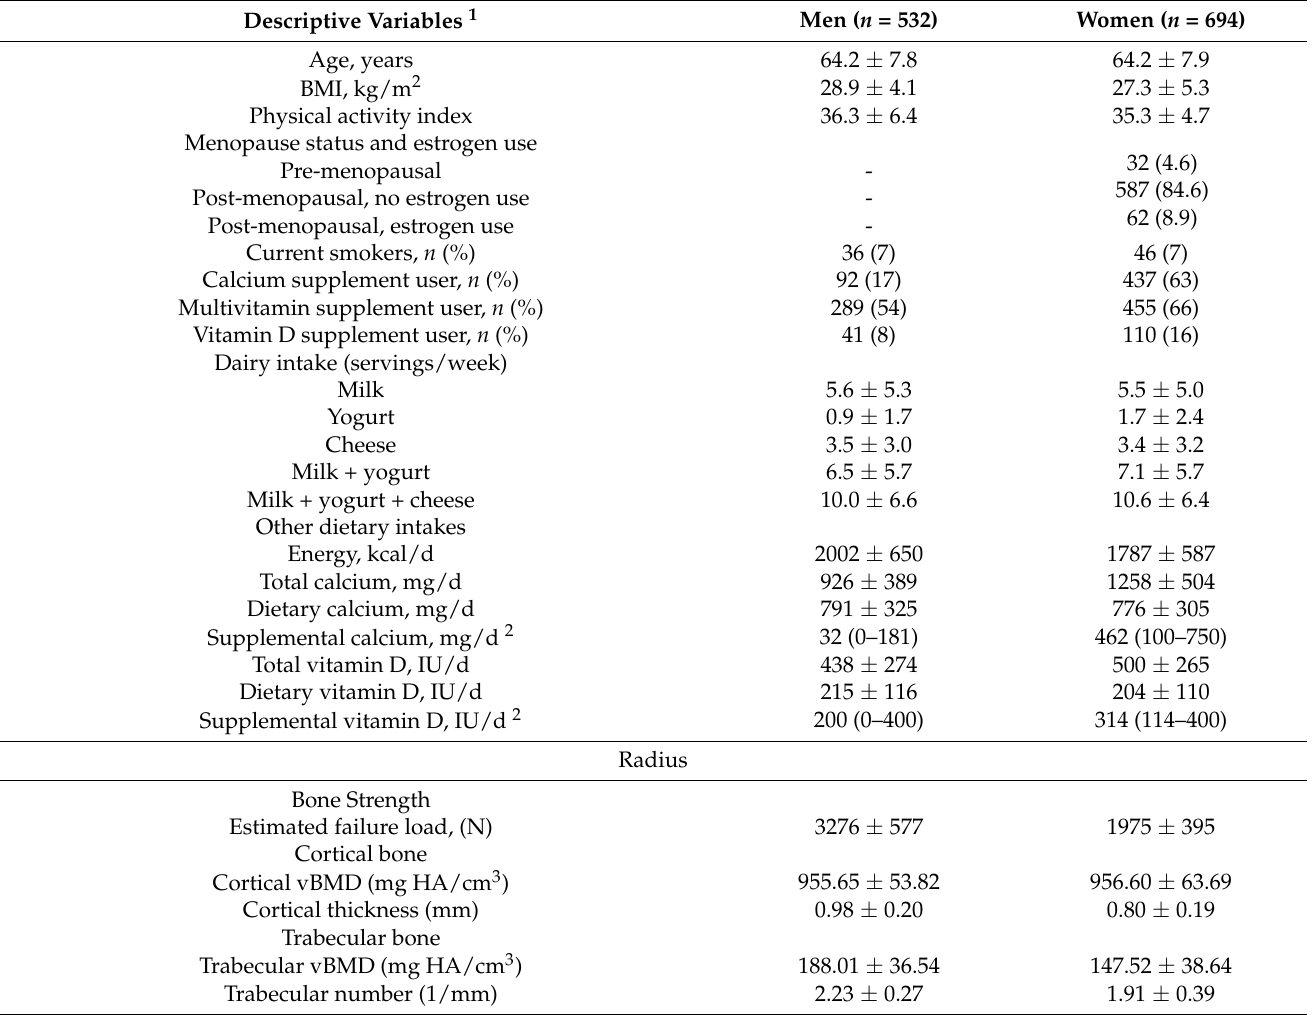
Table 1. Baseline characteristics of the men and women in the Framingham Offspring Study for Tibia HR-pQCT analysis. Descriptive Variables